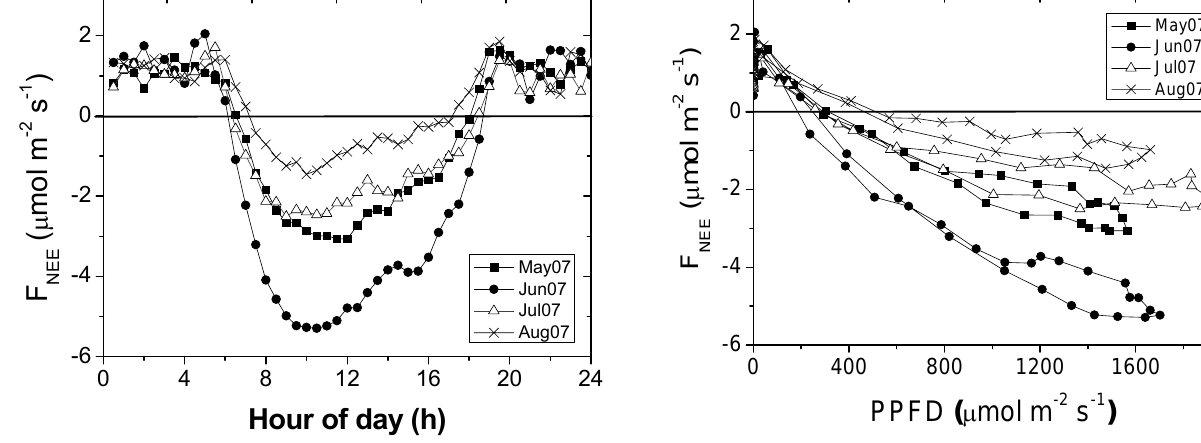
Fig. 5a. Mean hourly NEE flux vs. PPFD during May, June, July and August 2007. Hysteresis was found for every month, with the temporal trend proceeding counterclockwise.